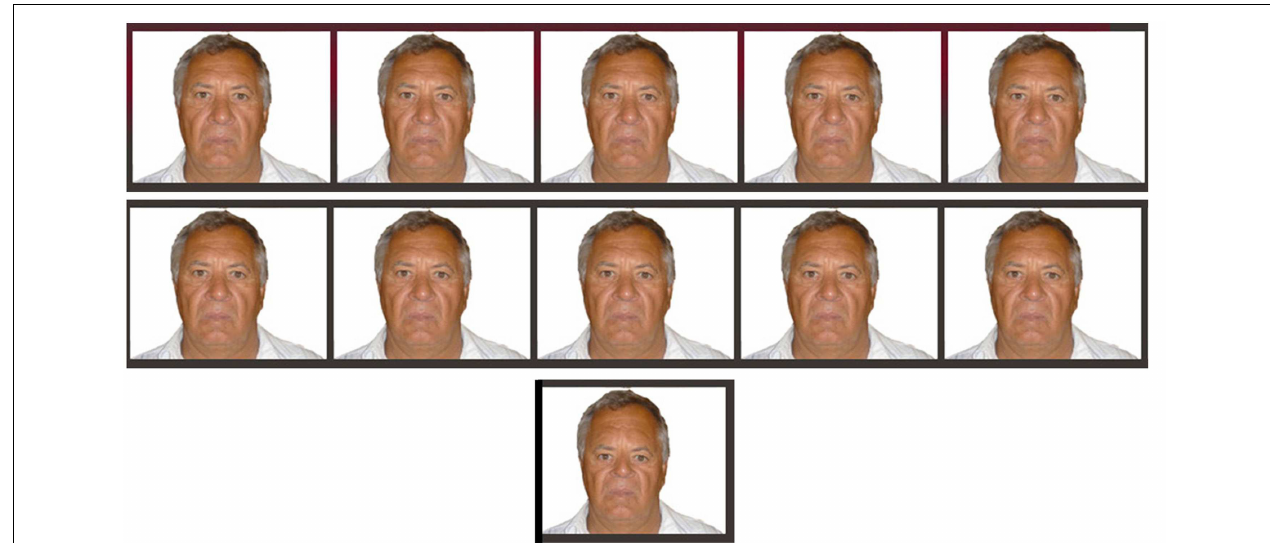
FIGURE 1 | Running from left to right, a complete set of images for a negatively distorted parent including test images ranging from − 1 through to − 10 as well as the adaptor image of − 25.